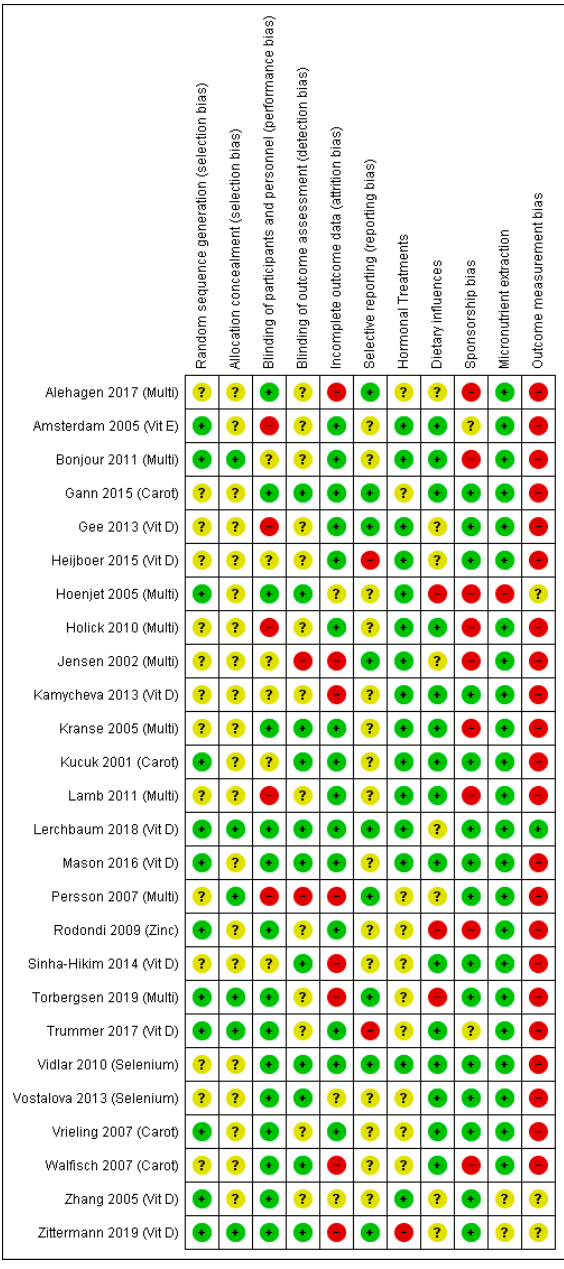
Supplementary Table S5, E. An overview of the risk of bias for RCTs is shown in Figure 2. We found no